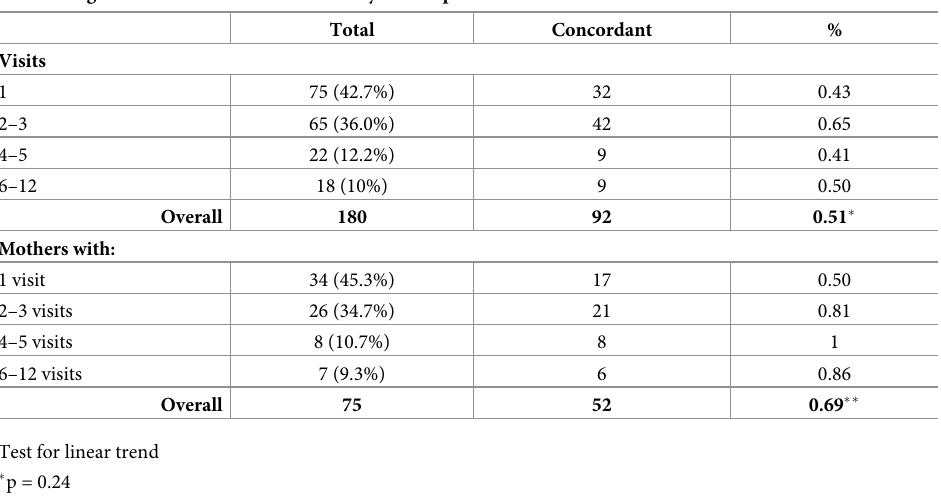
Table 2. Agreement across numbers of survey-record